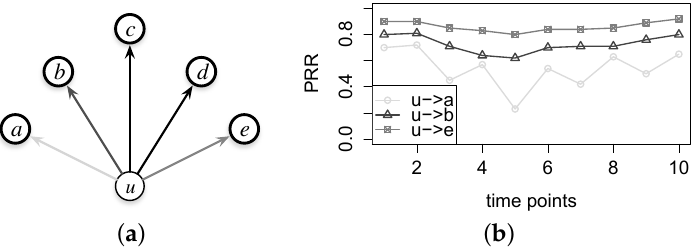
Figure 17. Conceptual illustration of the link correlation. ( a ) Demo of incident links; ( b ) Patterns of the PRR variations.